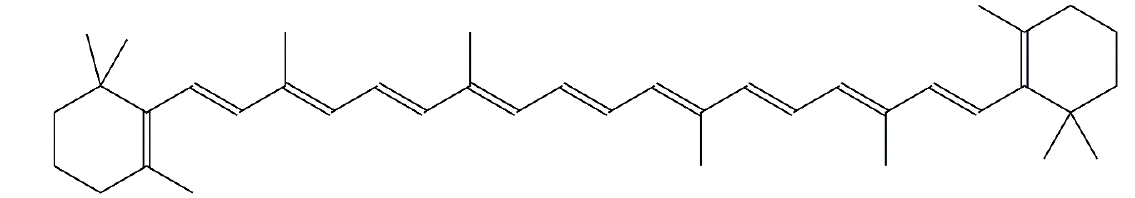
Figure 5. Structure of β -carotene.